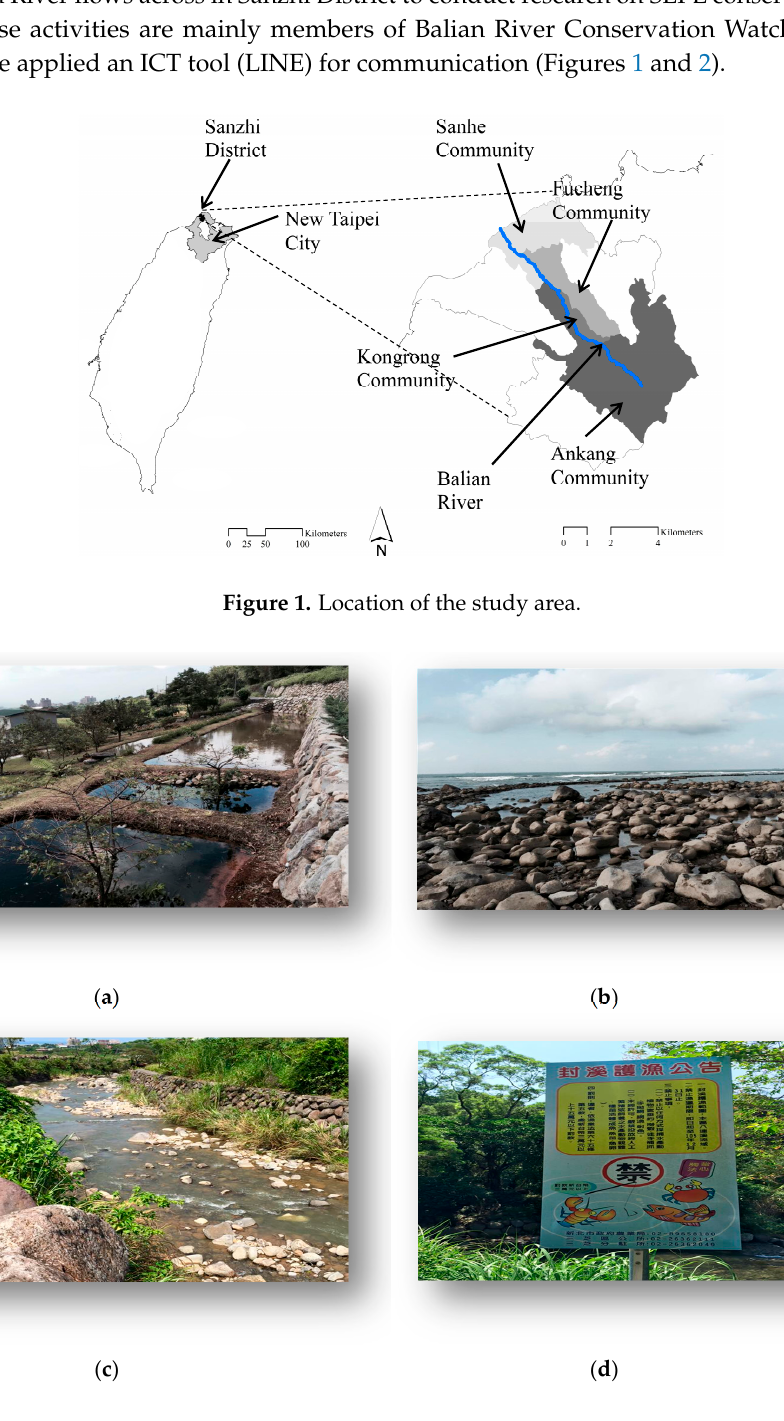
Figure 2. Site photos of surroundings of SEPLs. ( a ) The agriculture along upstream Balian River; ( b ) The downstream of the river; ( c ) The middle stream of the river; ( d ) Fishing activities prohibited along the